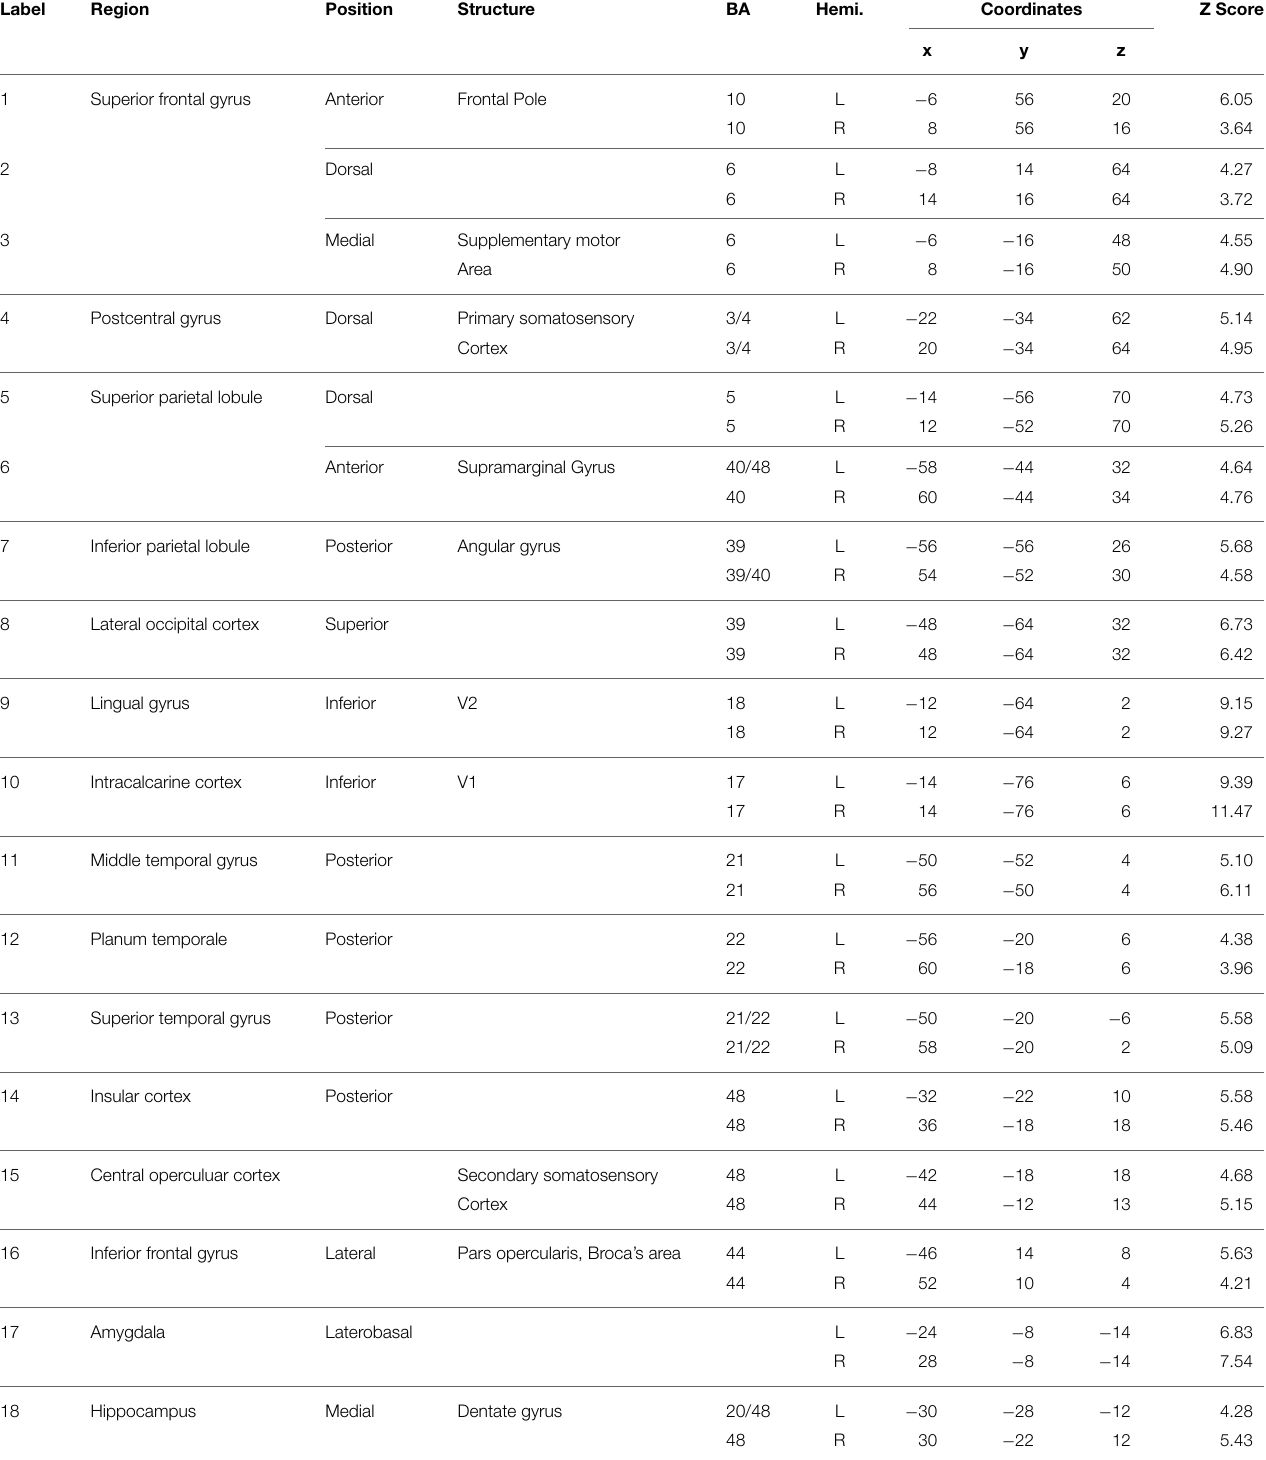
TABLE 2 | Brain regions showing a significant BOLD response while participants viewed expressive whole-body movement sequences. Label Region Position Structure BA Hemi.